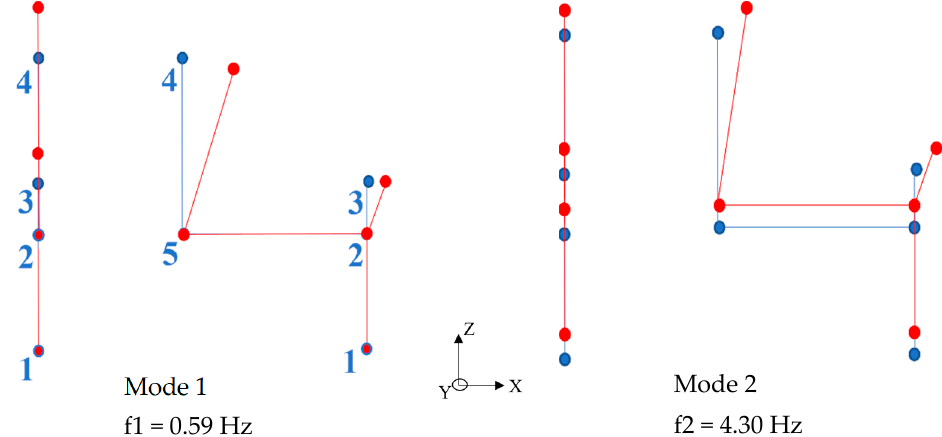
Figure 20. Comfort seat experimental modal parameters, where the front and lateral views are presented.